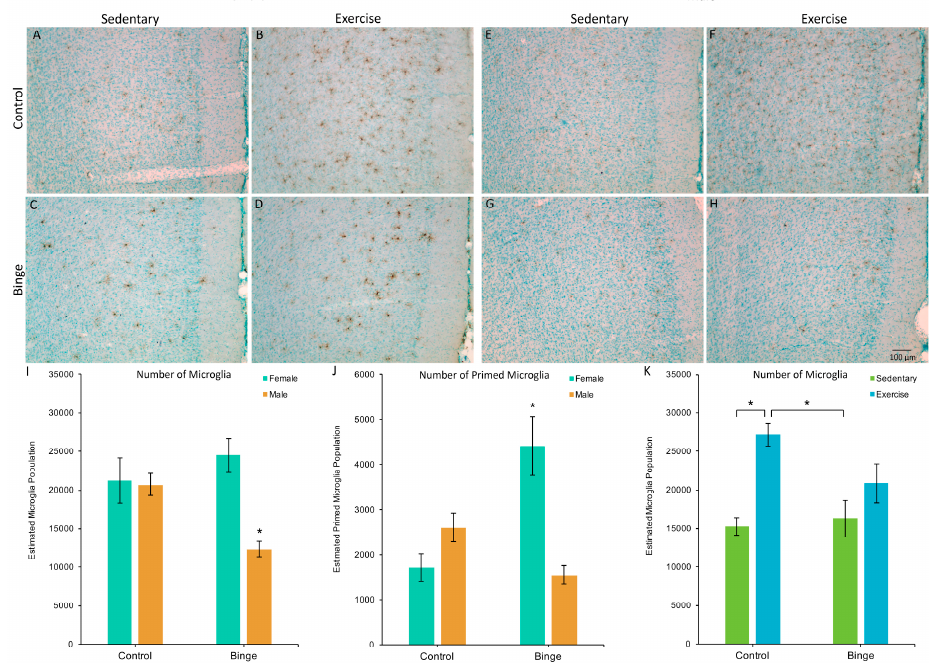
Figure 2. The effects of binge alcohol and exercise on microglia in the medial prefrontal cortex (mPFC) of females ( A – D ) and males ( E – H ); images of Iba1 staining in the mPFC captured at 10×. Binged males had fewer microglia in the mPFC compared to all other groups ( I ). There was a binge-induced suppression of exercise-induced microglial plasticity ( K ), as exercise increased microglia numbers in control, but not binged animals. For morphologically primed microglia ( J ), binged females had more compared to all other groups. * p <